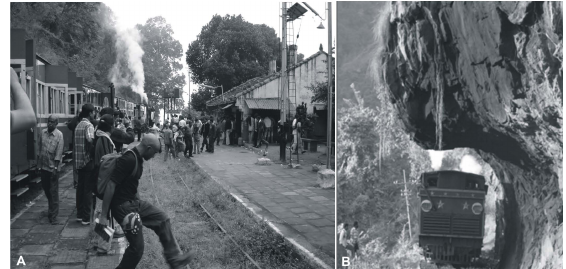
Fig. 3. Nilgiri toy train at Hillgrove railway station (A) and train crossing a half tunnel structure in a landslide zone (B) .